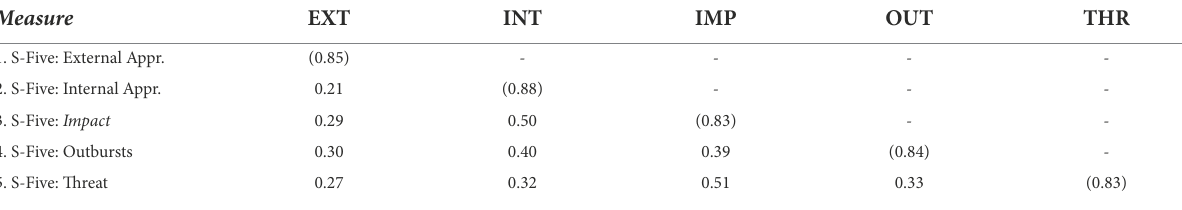
TABLE 1 Internal Consistencies and Intercorrelations of the S-Five from the Original Validation